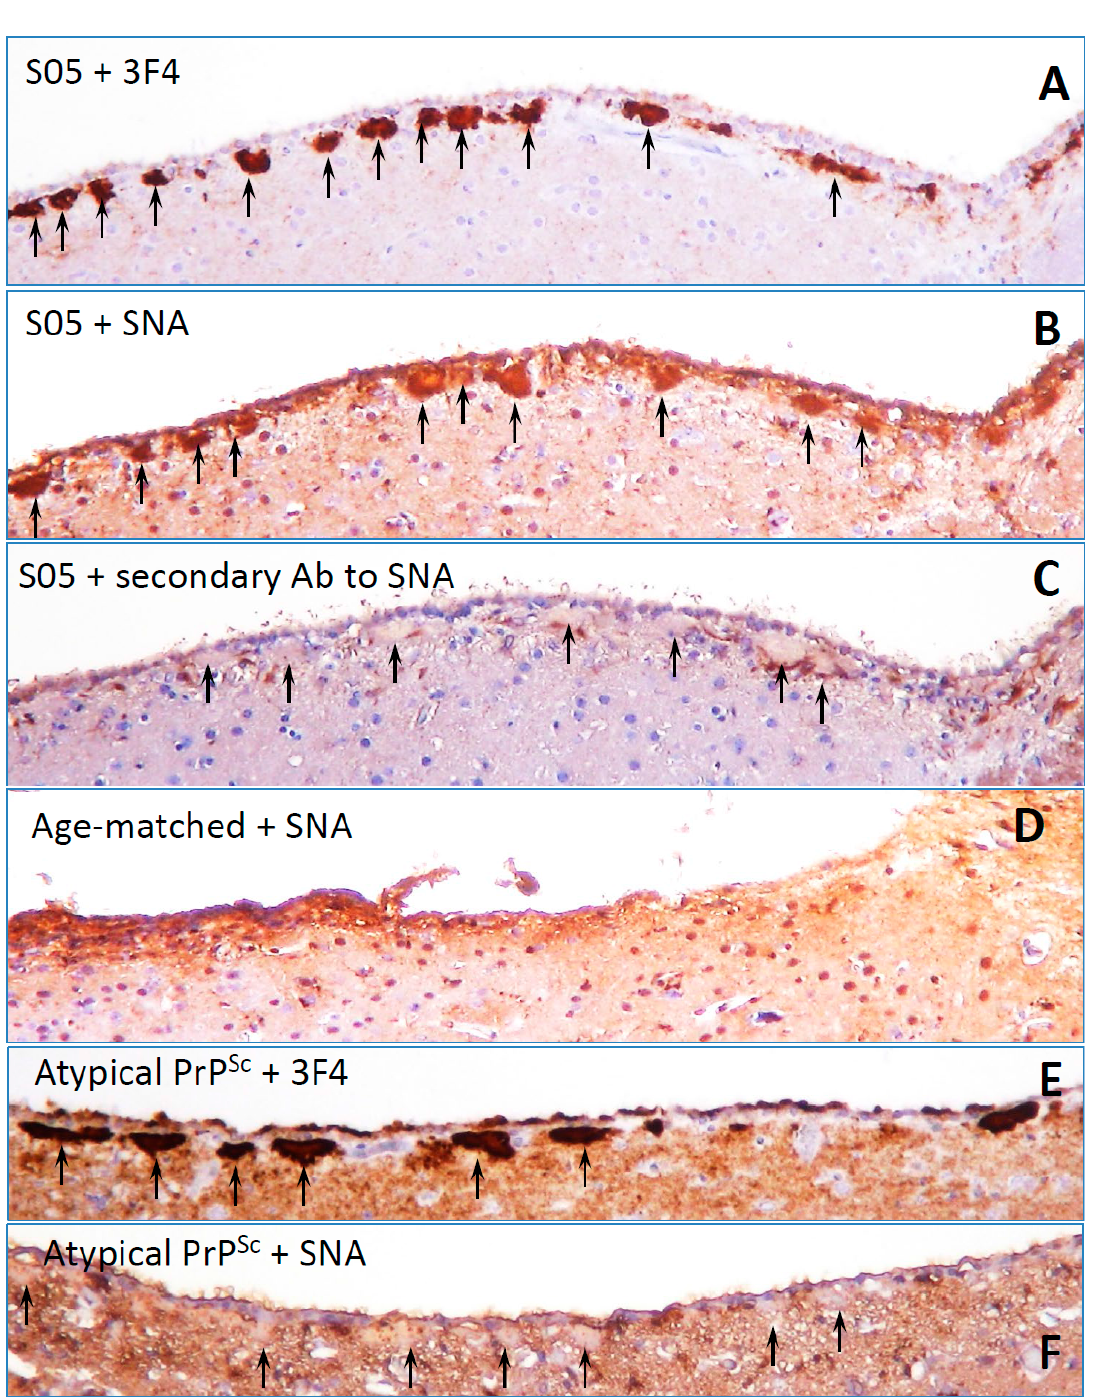
Figure 1. Staining of PrP Sc plaques with SNA lectin. Images of SO5 PrP Sc plaques ( A-C ) or atypical PrP Sc plaques ( E, F ) in hamster brains stained with anti-PrP 3F4 antibody ( A, E ), SNA lectin ( B, F ), or secondary antibody used for SNA staining as negative control ( C ). Plaques are shown by arrows. Staining of normal age-matched control with SNA lectin is shown in D . Brains fixed in 10% neutral